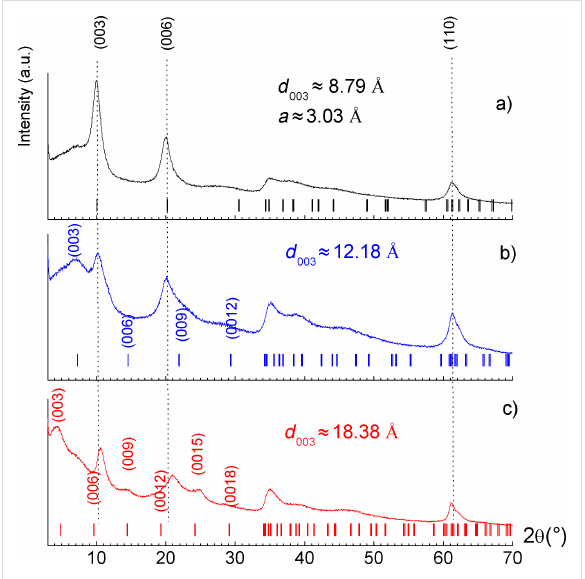
Figure 1: XRD patterns of Mg 2 Al hybrids: a) LDH/nitrate, b) LDH/HIS and c) LDH/PHE. The ticks under the peaks give the positions of the Bragg reflections assuming 3R